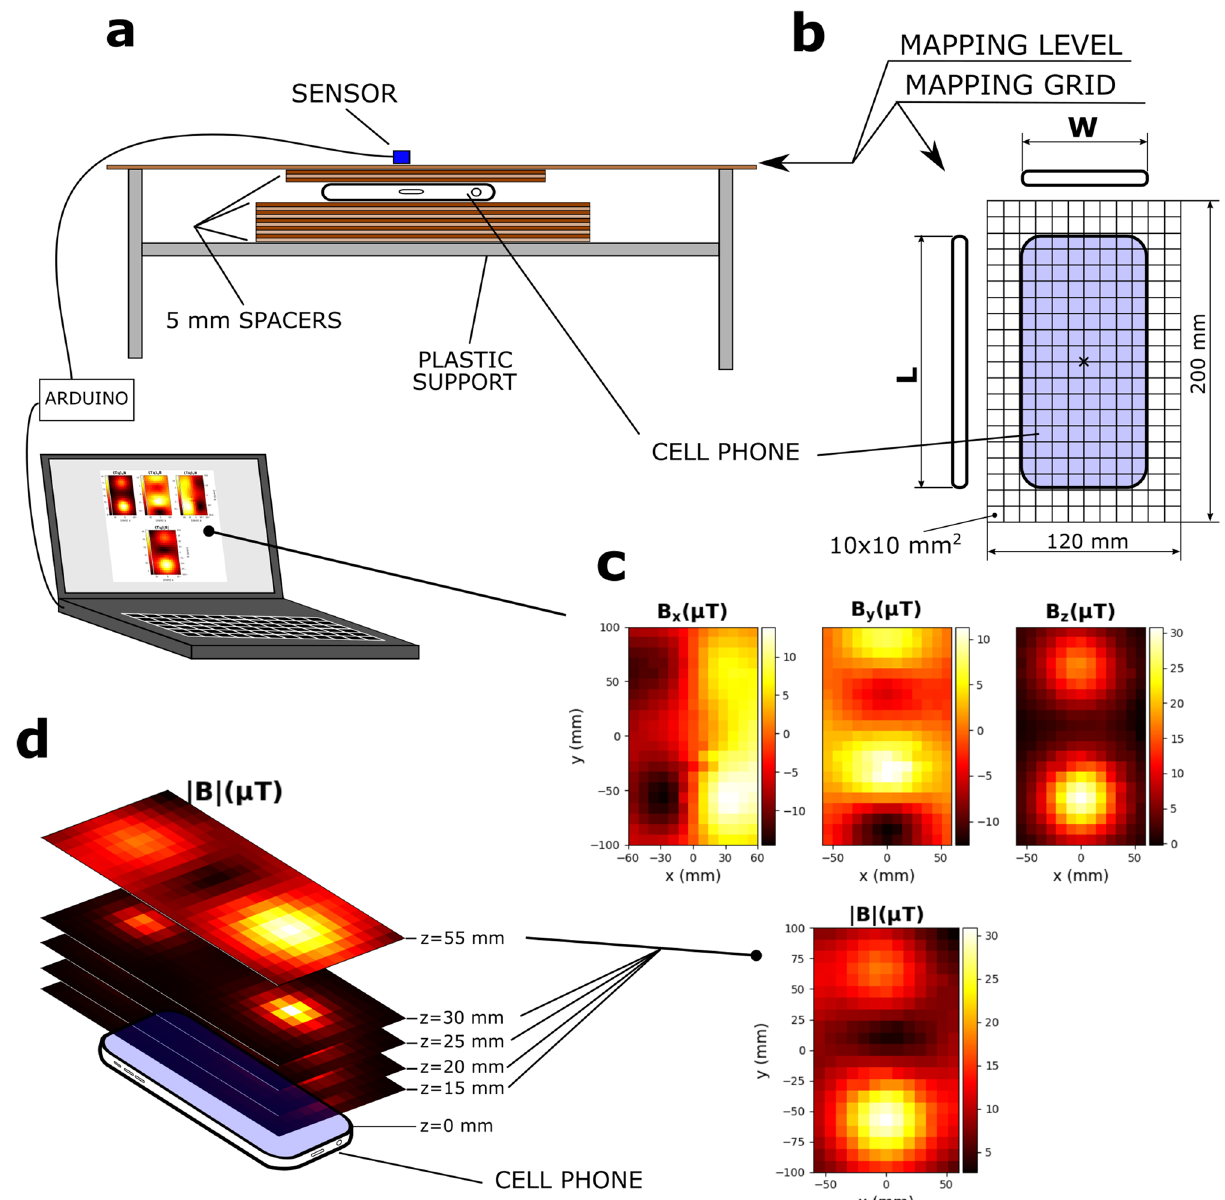
Figure 1. Experimental set up. ( a ) A mobile phone is placed on top of a stack of 5 mm thick PMMA spacers, just below a pane of PMMA which serves as the mapping level. Spacers are also placed above the mobile phone to better guarantee the desired distance and parallelism to the mapping level. On top of the mapping level a grid ( b ) is placed to assist the (manual) placing of a sensor connected to a PC through an ARDUINO board. After all points of the grid are measured with the 3-axis sensor, three maps are generated (one for each of the field’s components, B x , B y , and B z ) and the map for the magnitude, |B|, is calculated ( c ). Then one (or more) spacer(s) is(are) removed, so the phone descends 5 mm (or more), increasing its distance from the mapping level, and the procedure of mapping is repeated. Before any phone was placed in site, the ambient background field was mapped. All mappings, for the background and for each value of z (15, 20, 25, 30, and 55 mm) ( d ) were done in